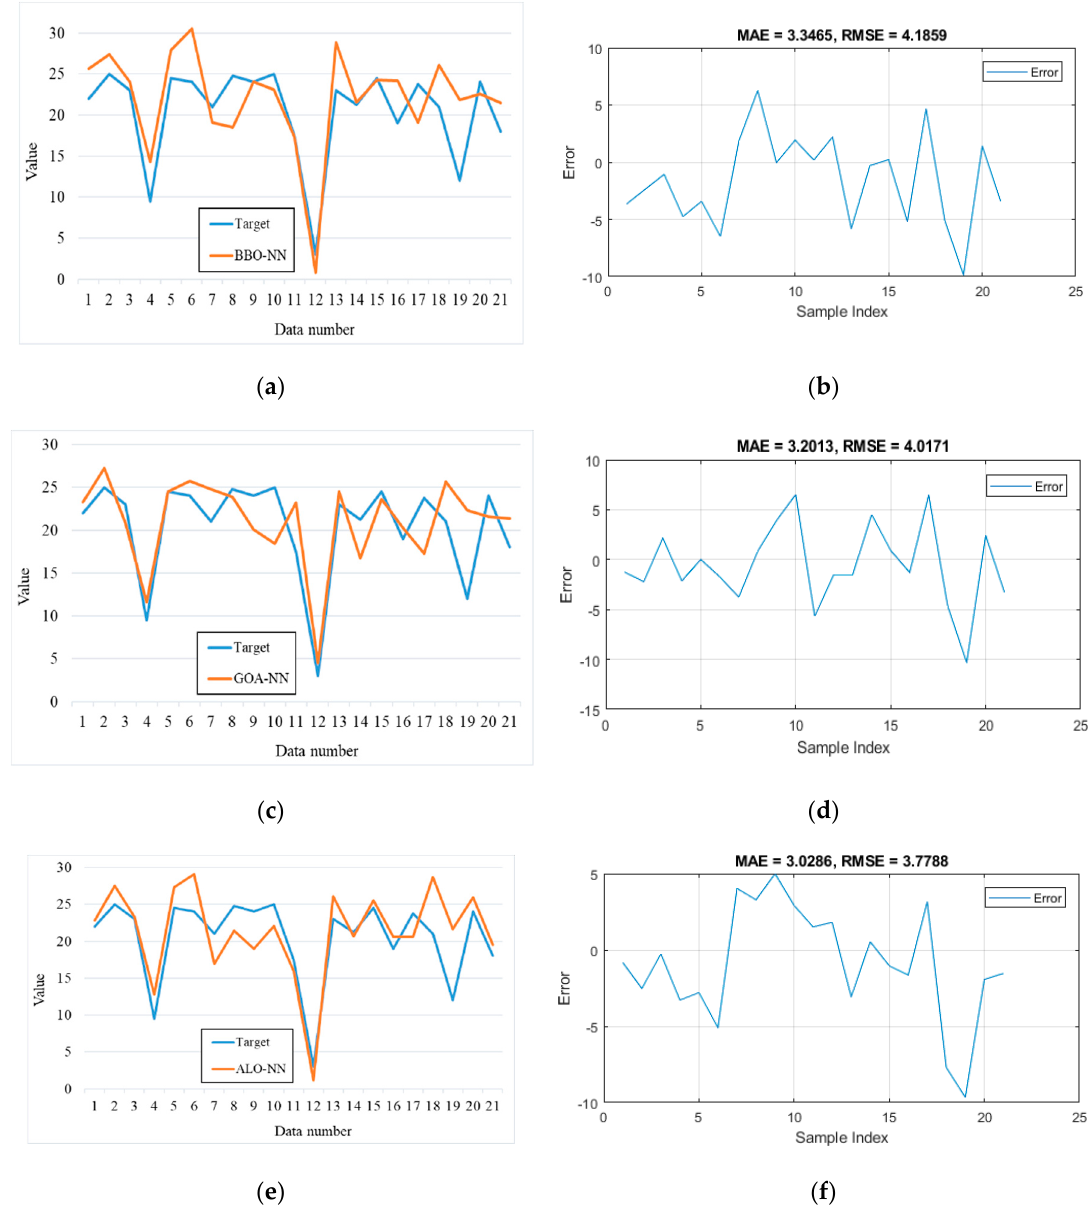
Figure 8. The testing results obtained for ( a , b ) BBO-NN, ( c , d ) GOA-NN, and ( e , f ) ALO-NN